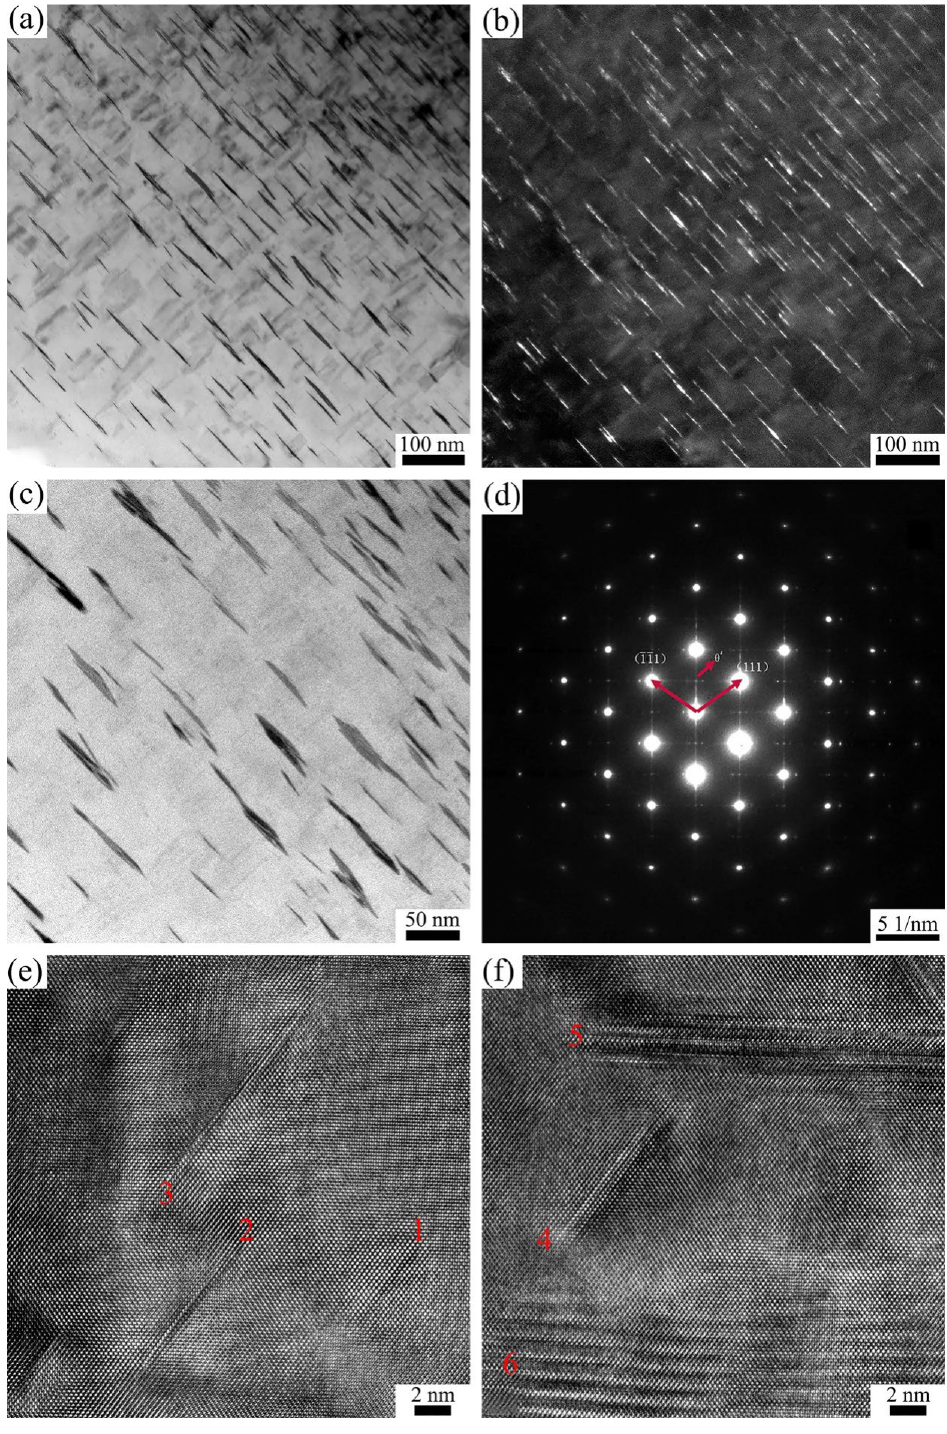
Figure 8. TEM bright field ( a , c ) and dark field ( b ) images, with selected diffraction spots (incident direction [011] Al) ( d ), and high-resolution images ( e , f ) of the precipitates in the intracrystalline phase. Considering the microstructure characteristics of the grain boundary precipitates and